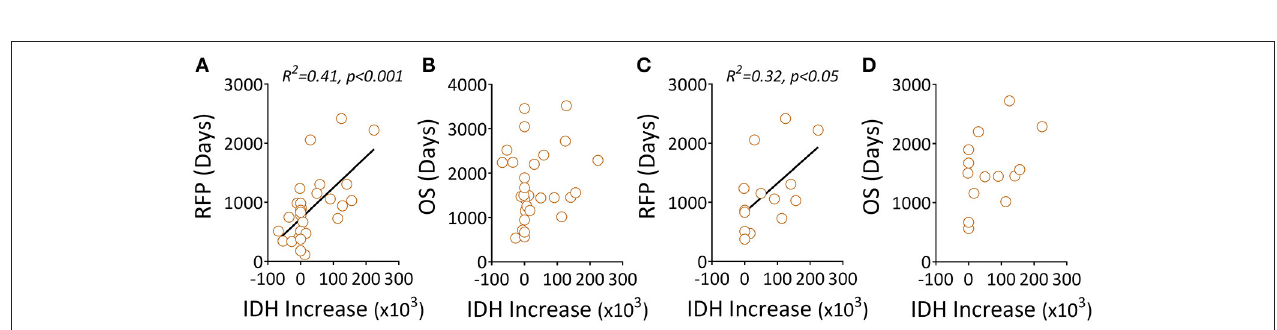
FIGURE 3 | Elevated levels of a mutant IDH1 protein associated with clinical outcomes in gliomas. (A,B) Recurrent tumors, including LGG-LGG and LGG-GBM, were evaluated for correlations between mutant IDH1 protein changes (before and after recurrence) and RFS/OS. (C,D) The data only show recurrent LGG-GBM tumors. Quantitation of mutant IDH1 protein expression in tumor samples was performed using Image Plus Premier 9.1 software. The relative values of the mutant protein in each tumor are the mean density of ten 20 × magnification fields. The IDH1 increase was the difference between recurrent and primary tumors featuring the IDH1 mutant protein. We used linear regression to estimate linear trend lines and R2 to test the strength of the association.